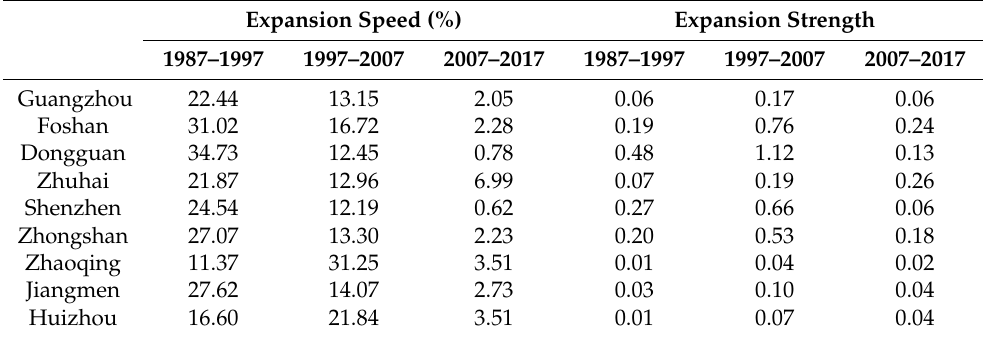
Table 2. Expansion speed and intensity of manufacturing production spaces in PRD in 1987–2017. Expansion Speed (%)